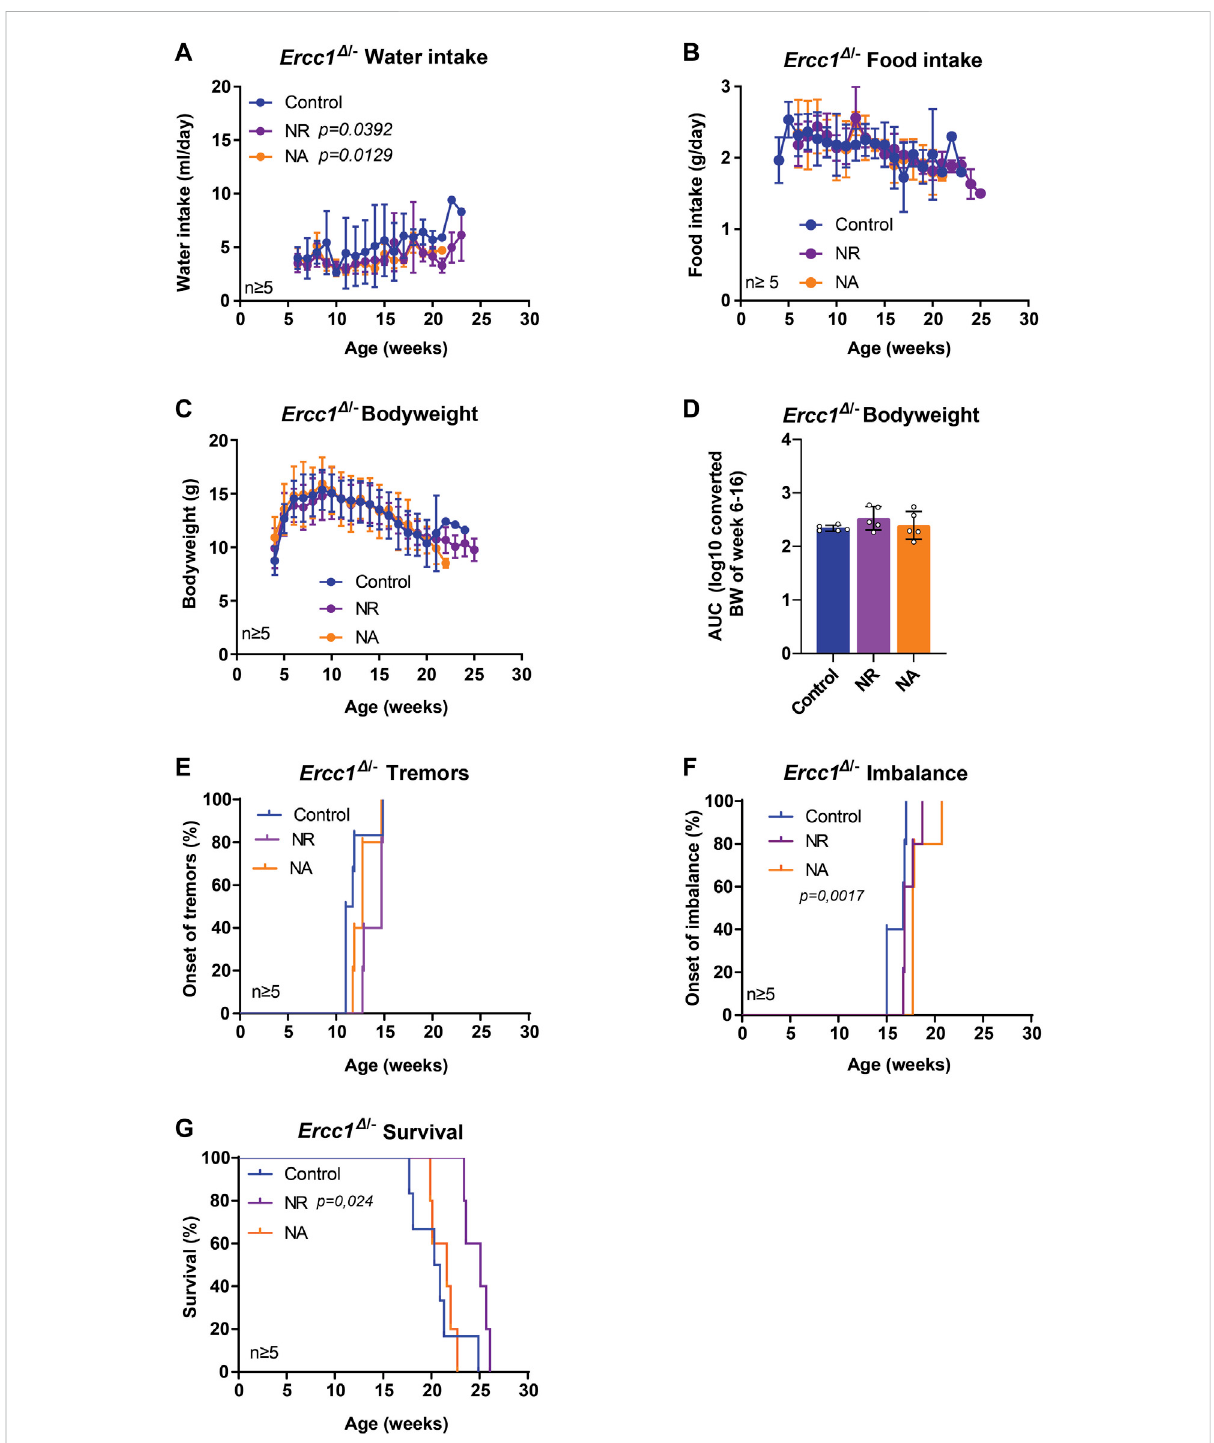
FIGURE 3 The effect of nicotinamide adenine dinucleotide (NAD + ) precursor ribosome supplementation on the lifespan and onset of neurological phenotypes of Ercc1 Δ / − mice. (A – C) , Values ofwater intake (A) , food intake (B) body weight changesover time (C) and body weight as area underthe curve (AUC) (D) in control animals and animals receiving supplementation of two NAD + precursors; NA and NR. (E – F) , Onset of neurological abnormalities;tremors (E) andimbalance (F) withageof Ercc1 Δ / − controlmiceandmicereceiving NRorNA. (G) .Survivalcurveshowinglifespan ofthethreegroups.IndicatedvaluesareMean(±SD). Signi fi cant p valuesoftheDunnet ’ smultiplecomparisontest (A) andlog-ranksurvivaltest (F,G) are